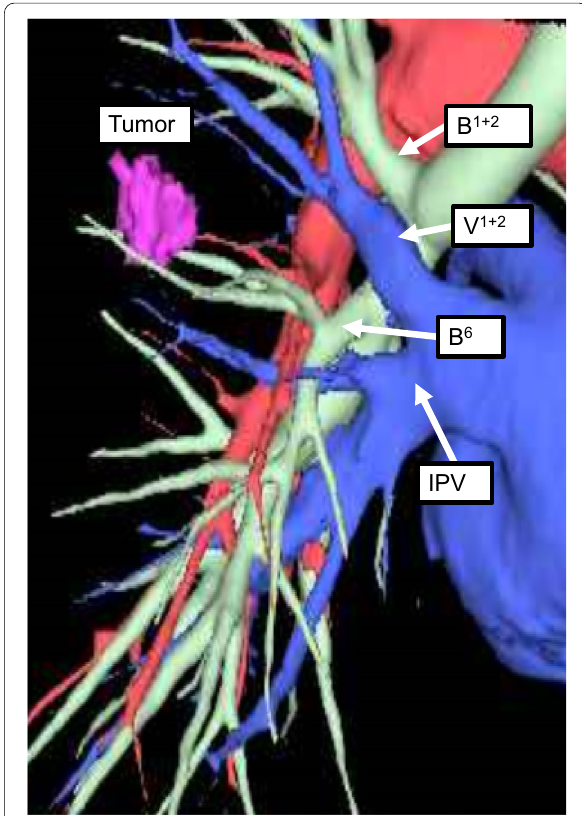
Fig. 2 A three-dimensional reconstructed image. SYNAPSE VINCENT was used to preoperatively construct a three-dimensional image of the patient’s anatomy. IPV inferior pulmonary vein